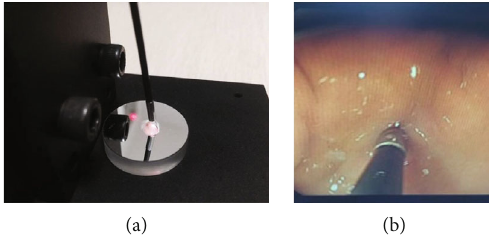
Figure 2: Representative images of the fi ber optic Raman system being used (a) in vitro and (b) in vivo.